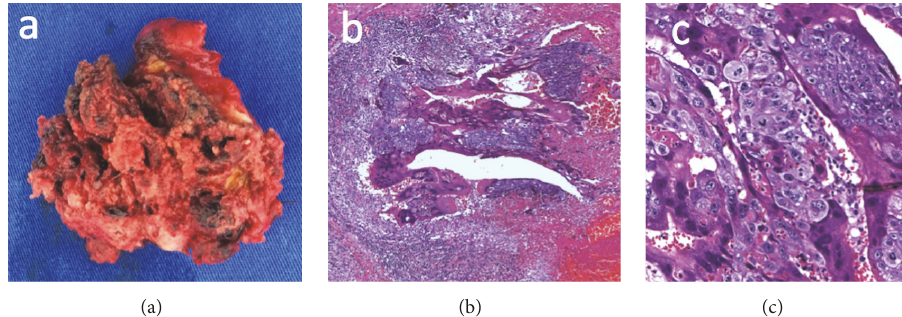
Figure 3: (a) Macroscopic appearance of the tumor. ((b) and (c)) Histological section of the tumor displaying clusters of abnormal syncytiotrophoblast and cytotrophoblast cells (hematoxylin-eosin staining, (b) × 50 magnification and (c) × 200